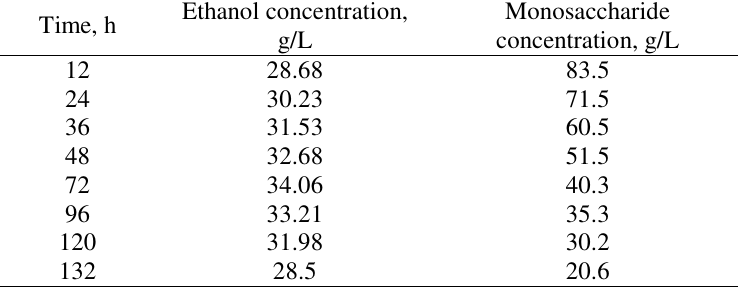
Table 4. Ethanol and monosaccharide concentration at various time intervals